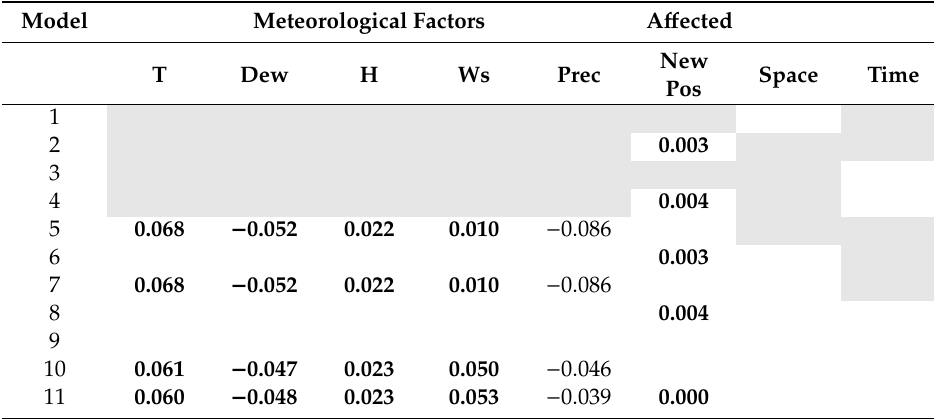
Table 1. Significant variable coe ffi cients of 11 fitted models (for PM 2.5 ).